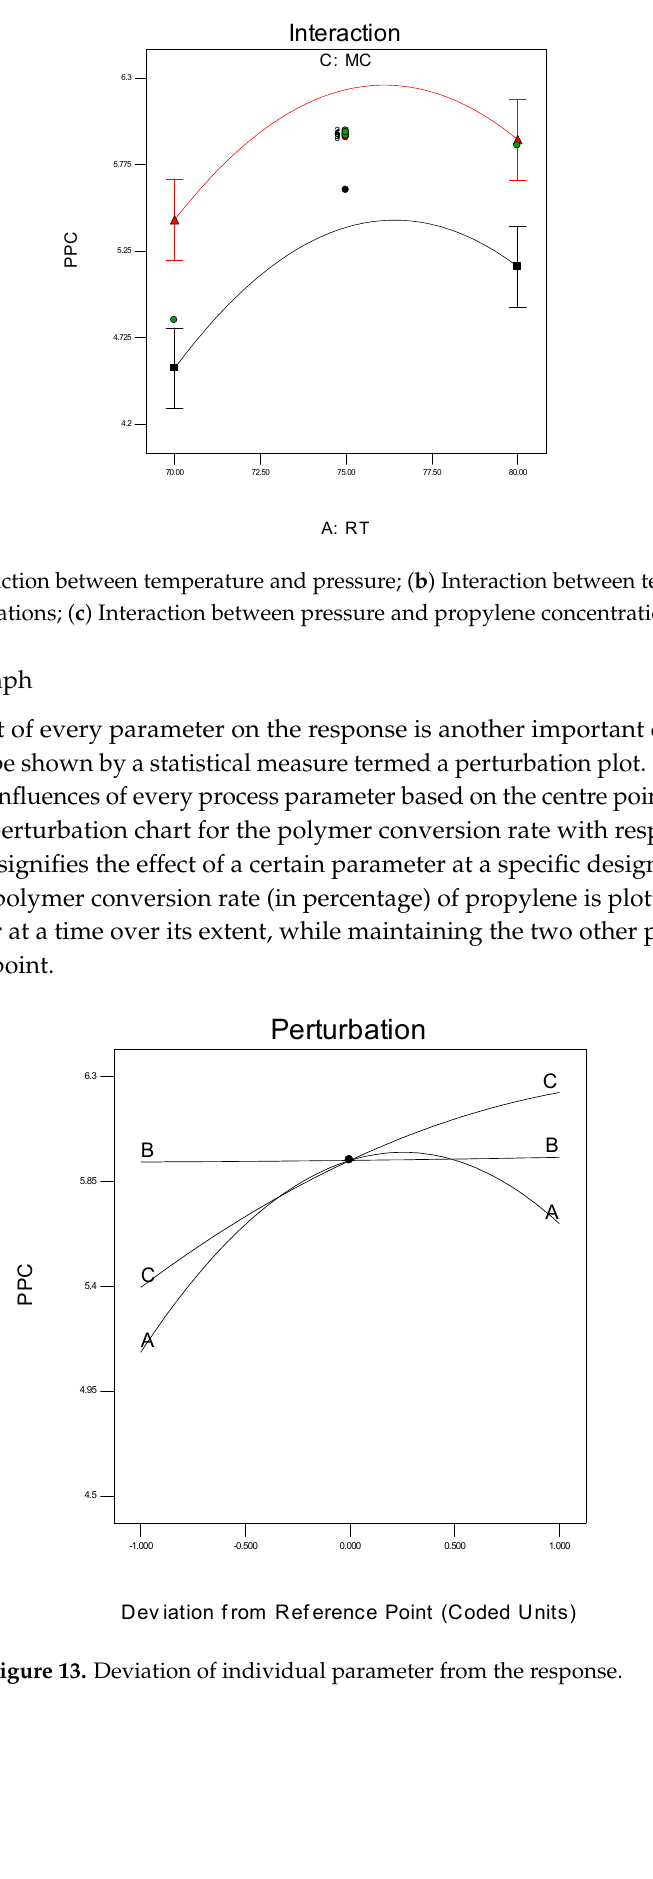
Figure 13. Deviation of individual parameter from the response.